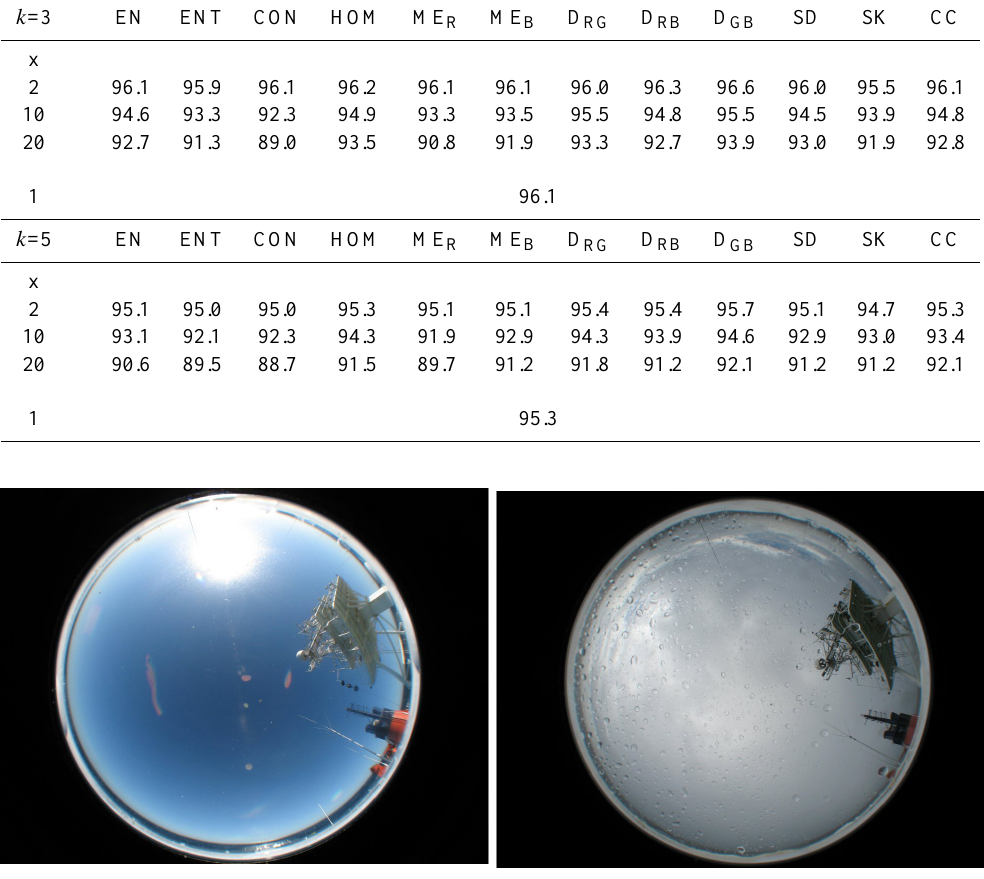
Fig. 3. Misclassification of clear sky caused by the “whitening effect” (left) and missclassification of stratus due to raindrops (right).